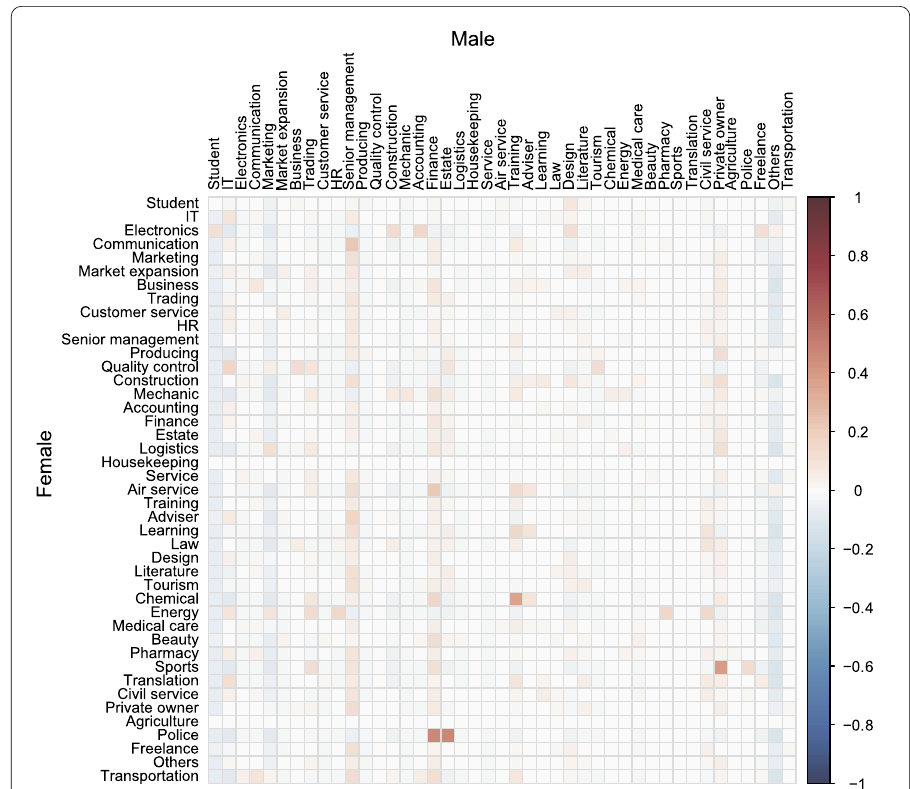
Figure 4 Employment preference for female users sending messages to male users. The vertical axis indicates the female occupations and the horizontal axis indicates the male occupations. Preference values are represented by different